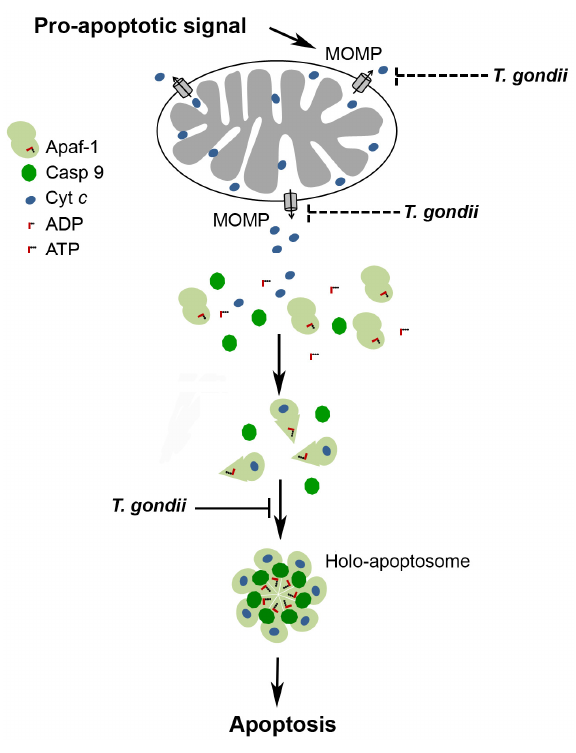
FIGURE 6: Model of the T. gondii -mediated inhibition of the caspase-dependent intrinsic PCD pathway. A cell-intrinsic pro- apoptotic signal leads via activation of pro-apoptotic Bcl-2 family members to MOMP and release of apoptogenic molecules includ- ing cytochrome c from mitochondria. Binding of cytochrome c to Apaf-1 and nucleotide exchange induce conformational changes that allow oligomerization of Apaf-1, caspase 9 recruitment and caspase activation. T. gondii inhibits the mitochondrial apoptotic pathway at least twofold: (i) by inhibition of MOMP [17, 30, 32, 37] and (ii) by inhibiting cytochrome c -triggered holo-apoptosome assembly (described herein). See main text for further